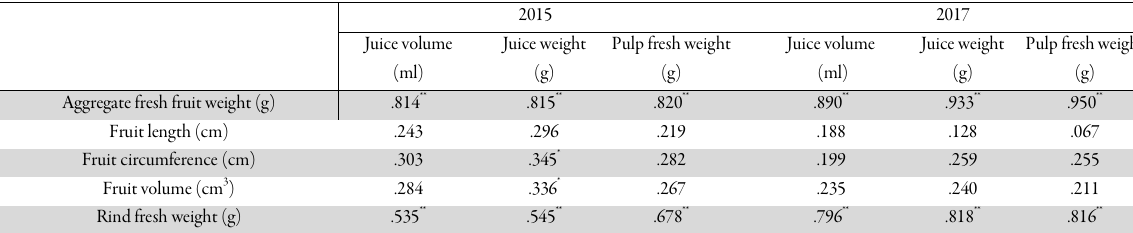
Table 10. Correlation coefficients of some fruit and juice metric traits in 2015 and 2017